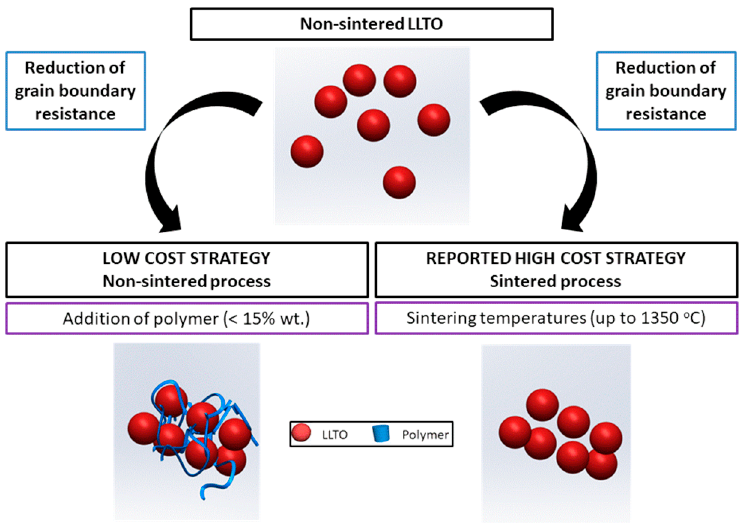
Figure 1. The strategy for a low-cost increased conductivity solid ceramic electrolyte followed in this work.